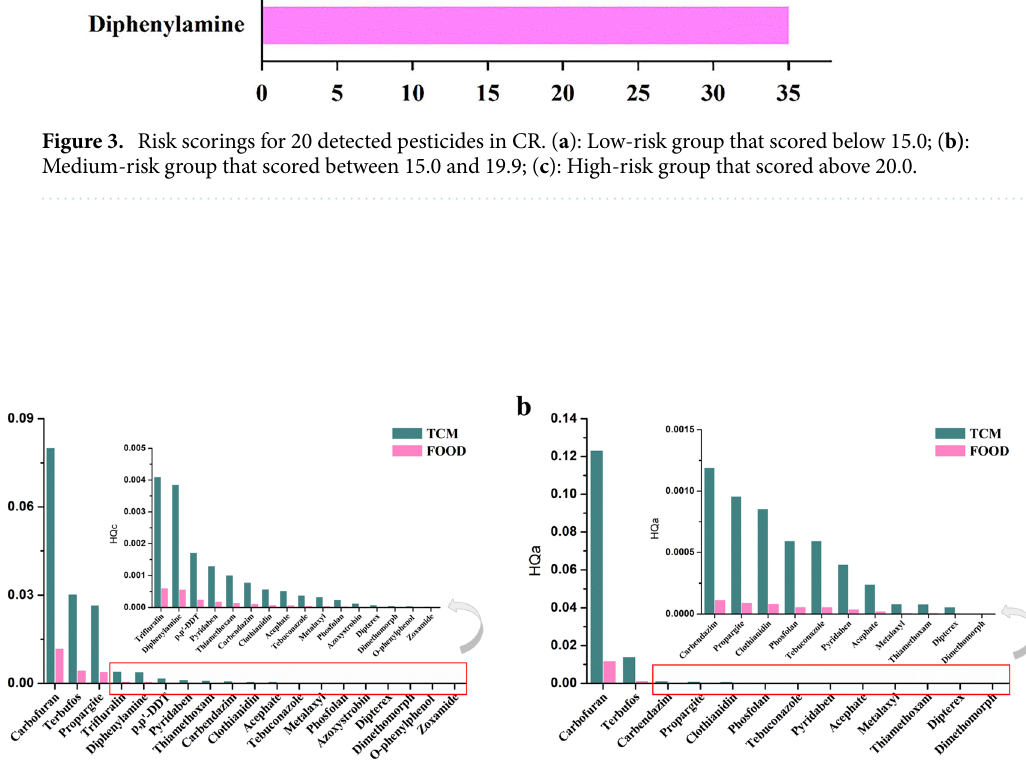
Figure 4. Results of Chronic ( a ) and Acute ( b ) risk assessment of pesticide residues in